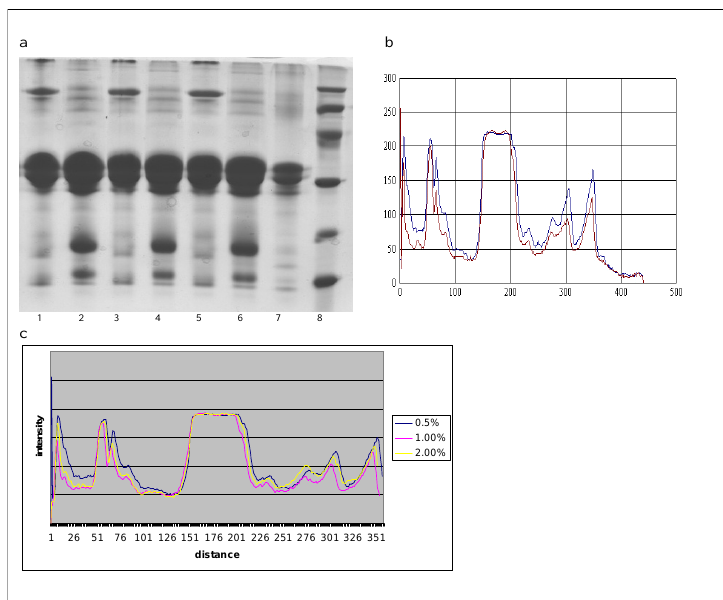
Figure 5 : The electrophoretic* and comparative densitometric analysis of the reconstituted skim milk with demineralized whey added, treated at 75 °C for 20 minutes. a. The electrophoretic analysis of the reconstituted milk with 0.5% (1, 2), 1.0% (3, 4), and 2.0% (5, 6) of demineralized whey added; Na- caseinate (7) and molecular weight standards (8). b. The comparative densitometric analysis of the heat treated samples without (-) and with (-) 0.5% of demineralized whey. c. The comparative densitometric analysis of samples treated with 0.5%, 1% and 2.0% of the demineralized whey added. *1, 3, 5 samples without 2-mercaptoethanol, and 2, 4, 6 samples with